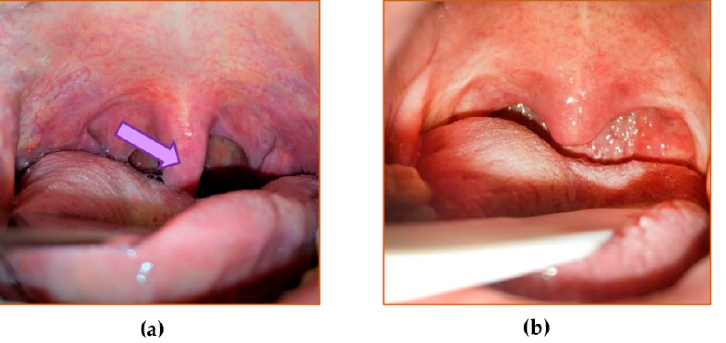
Figure 1. Oropharyngeal view before and after palatopharyngoplasty in a participant suffering from moderate obstructive sleep apnea syndrome (OSAS). ( a ) The view before the surgery. The elongated, thick uvula with an enlarged ovular mucosa (arrow) and webbing of the posterior pillars are shown. ( b ) The view two months after the surgery. The reduction of the mucosa of the uvula is shown.